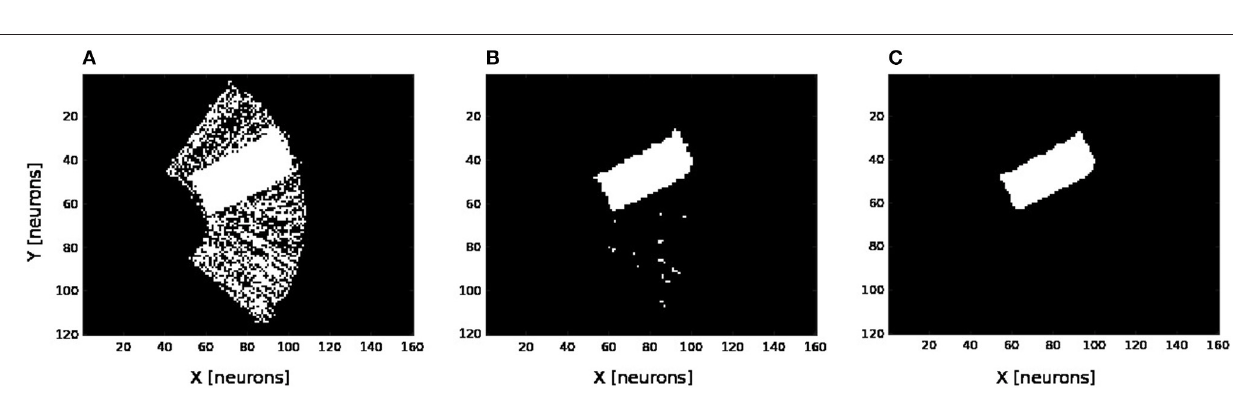
FIGURE 6 | Visual prediction of the complete tactile RF distribution and of the whole arm location. Visual perceptron units estimate the visual location of each tactile-motor GF unit (i.e., the body schema). The learning is done only when a visual target touches the arm and depends on the specific tactile location on the artificial skin and on the specific arm motor angle. By activating virtually all the tactile units and for a specific motor configuration, it is possible to display the density distribution of the arm location in the visual field. The results are presented for four different motor positions: 20 ◦ , 50 ◦ , 70 ◦ , and 100 ◦ , respectively (A–D) .